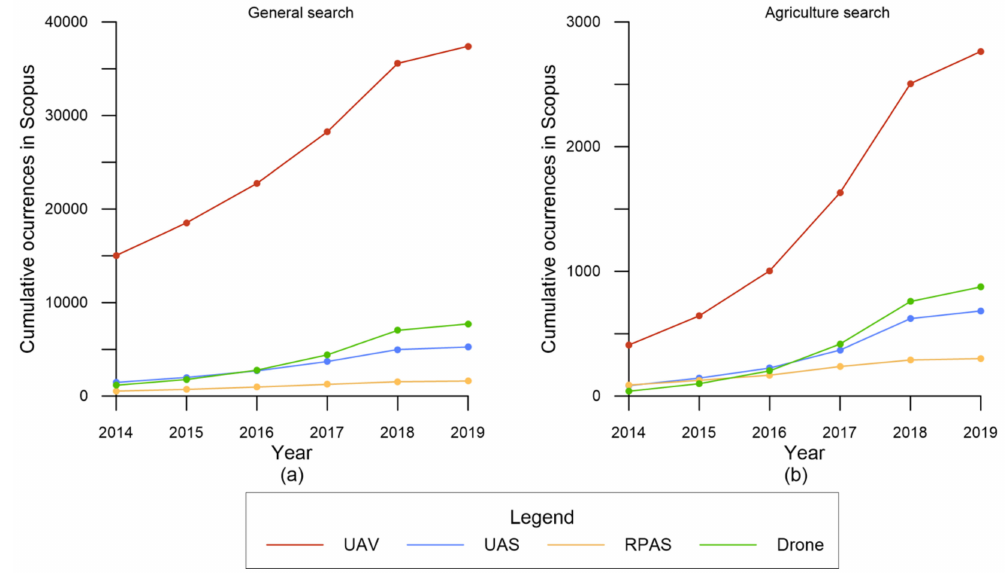
Figure 1. Cumulative of UAS technology items added to Scopus from 2014 to 2019: ( a ) General search and ( b ) Agriculture